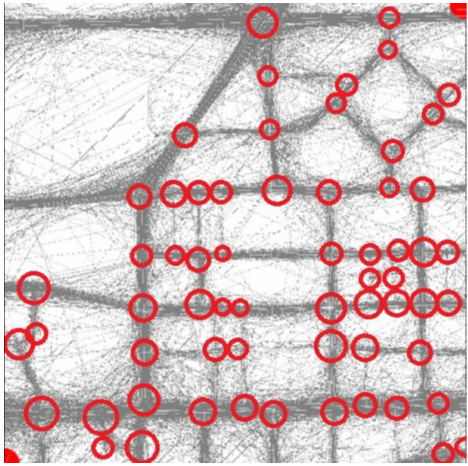
Figure 10. Shenzhen dataset (partial) and existing road